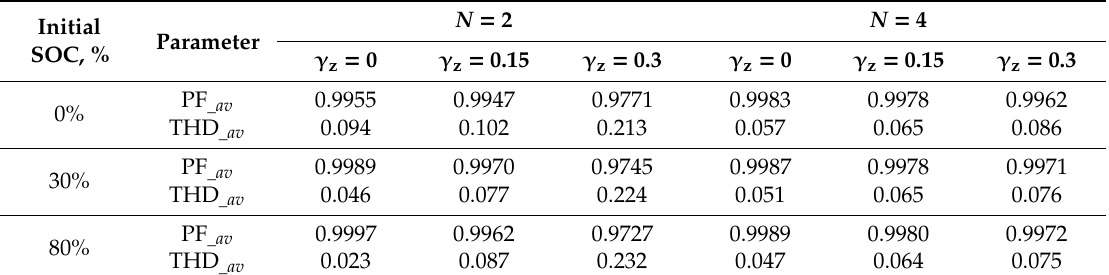
Table 3. Average power factor (PF) and Total Harmonic Distortion (THD) during the charging.